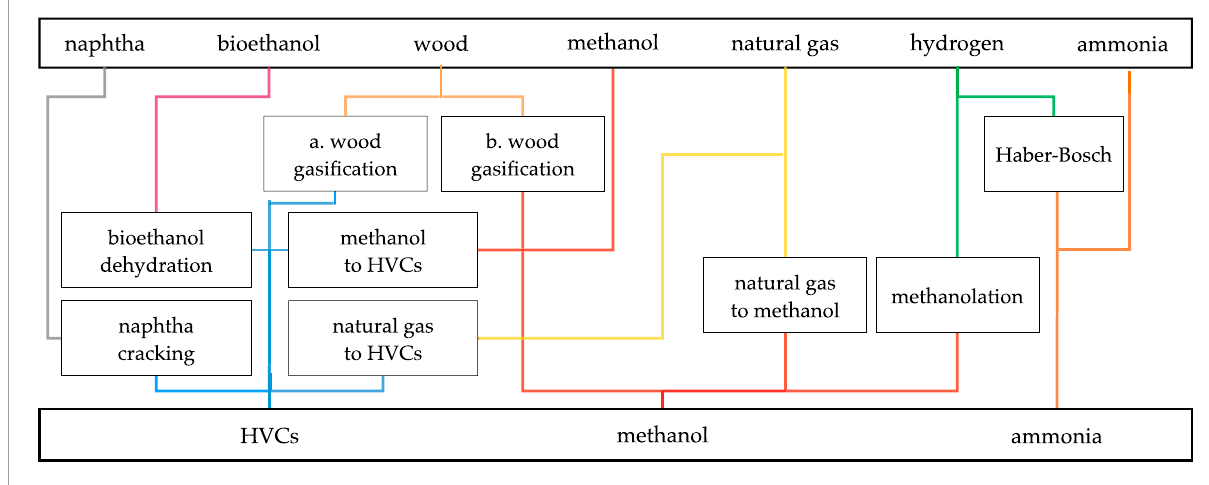
FIGURE 1 Schematic representation of the models of the conversion technologies used to represent the non-energy end-use demand. Details of the price of the resources can be found in Table 2 . The efficiency and the investment cost of each conversion technology are reported in Table 3 . In the study, “wood” and “woody biomass” are used with no distinctions.